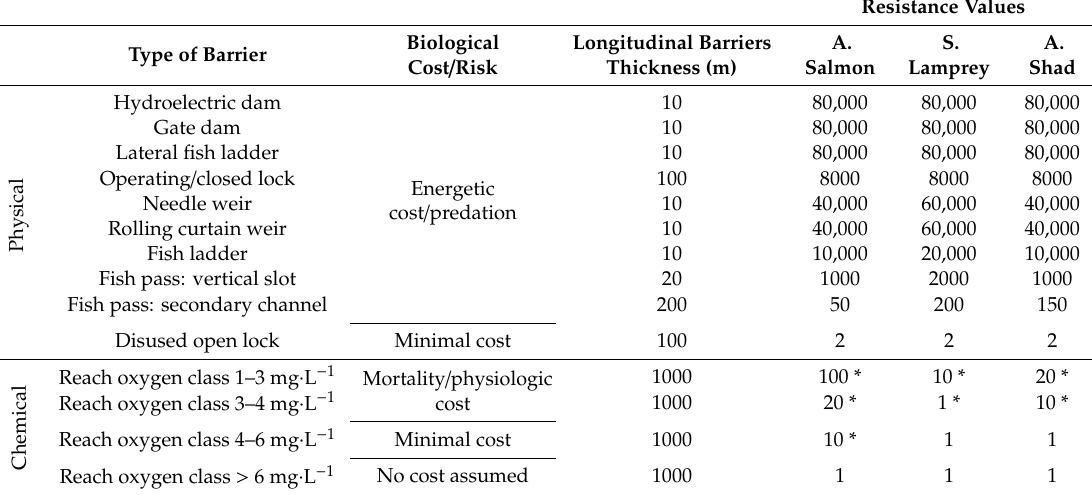
Table 2. Values of resistance (dimensionless) for the di ff erent type of physical and chemical barriers and associated biological costs and risk. Predation risk is associated with potential predation by other species or poaching when crossing physical barriers. For the accessibility scenario with only physical barriers, the resistance values marked with an asterisk (*) become R =